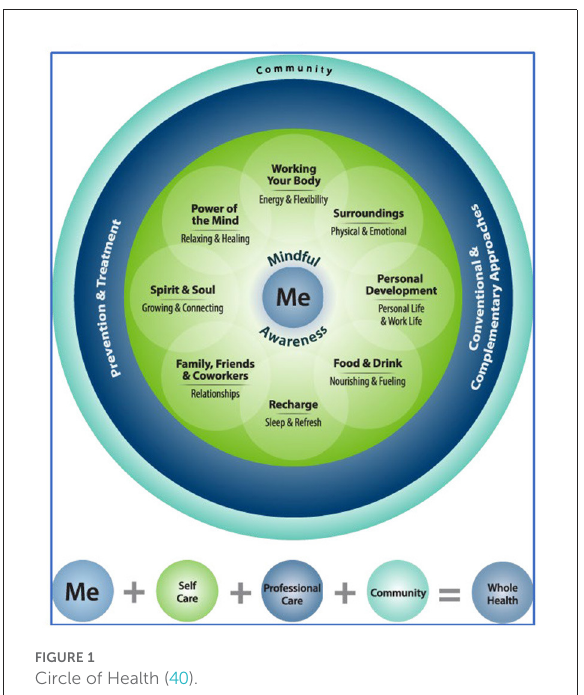
FIGURE1 Circle of Health